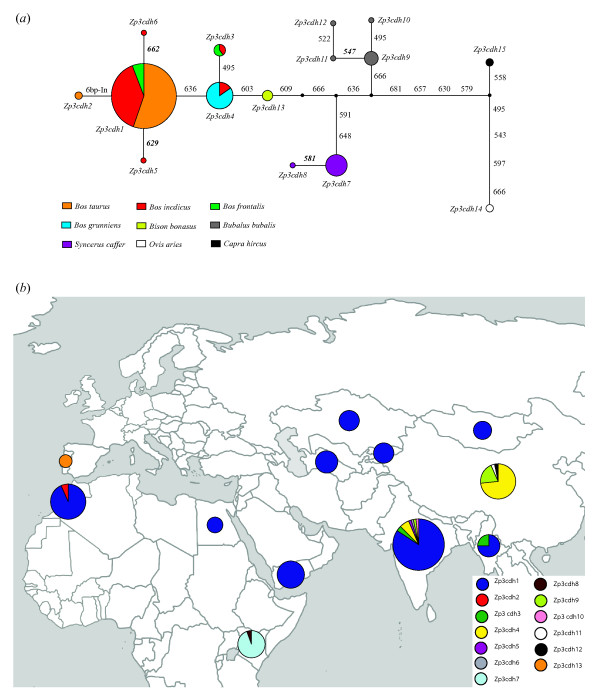
The median-joining network (a) and geographic distribution (b) of the Zp3 coding haplotypes. Numbering of mutations follows the full coding sequence of the bovine Zp3 gene (from base 1 to 1266). The 6-bp insertion (or two-codon repeat) is located at the relative positions between 609 and 620 or between 603 and 604. Nonsynonymous mutations are shown in bold and italic. The size of each circle is proportional to its frequency in numbers of chromosomes. The haplotypes Zp3cdh14 and Zp3cdh15 from the outgroup species are not shown in the geographic map.